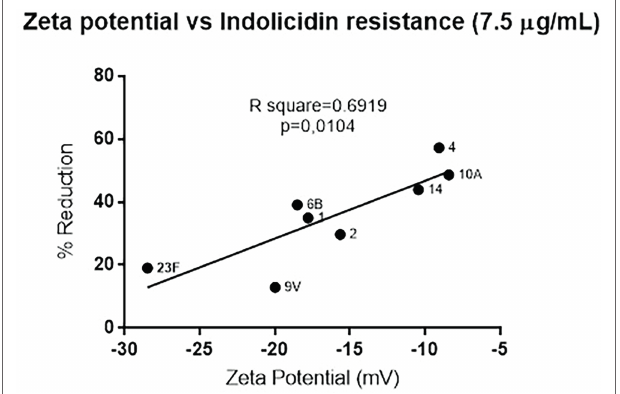
FIGURE 2 | Correlation between of Streptococcus pneumoniae surface charge and resistance to killing by indolicidin. Surface charge was determined by calculating the zeta potential of each individual serotype. Resistance is represented by the percent reduction of each bacterial strain after 1 h treatment with 7.5 μ g/ml indolicidin. Statistical analysis was performed using Pearson’s